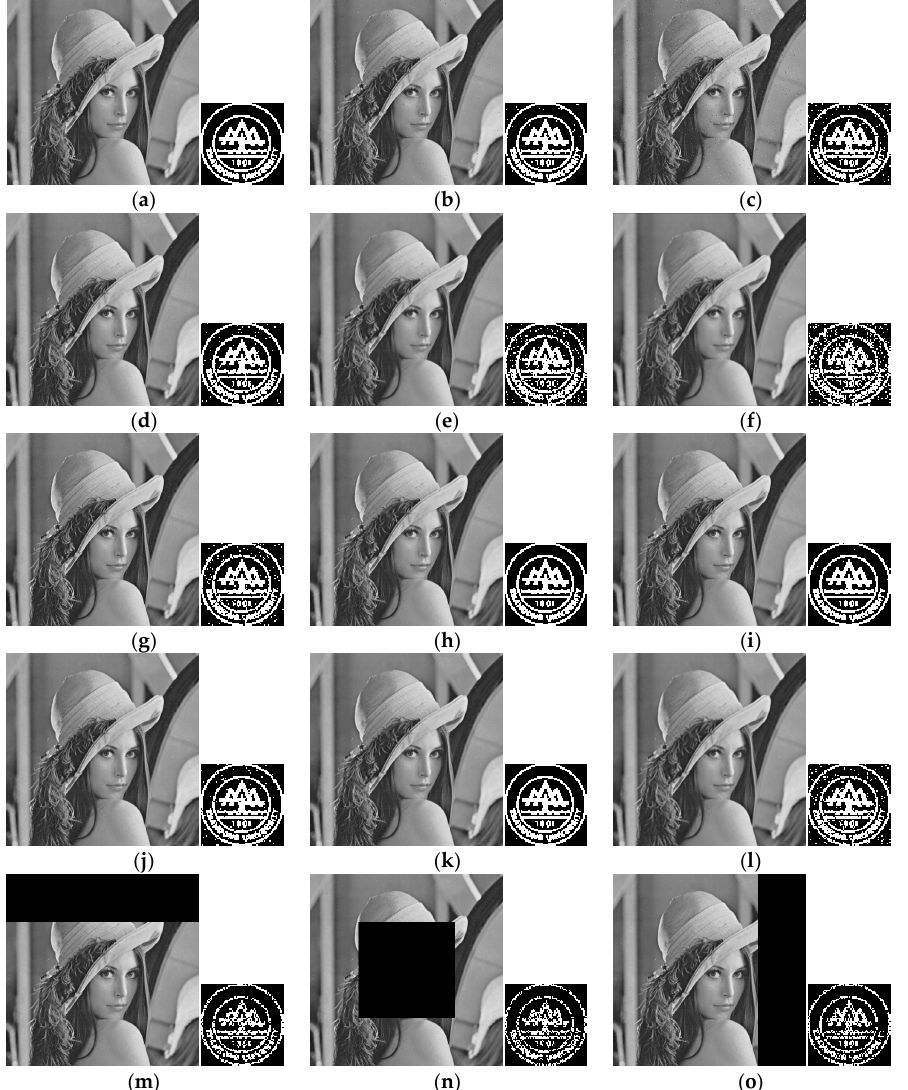
Figure 6. Distorted images and the extracted watermarks: ( a ) No attack; ( b ) Salt and pepper noise (0.001); ( c ) Salt and pepper noise (0.005); ( d ) Gaussian noise (0, 0.0001); ( e ) Median filter (3 × 3); ( f ) Average filter (3 × 3); ( g ) Image sharpening; ( h ) JPEG (quality factor Q = 90); ( i ) JPEG ( Q = 80); ( j ) JPEG ( Q = 70); ( k ) Rescaling (2, 0.5); ( l ) Rescaling (0.5, 2); ( m ) Cropping (top 25%); ( n ) Cropping (middle 25%); ( o ) Cropping (right